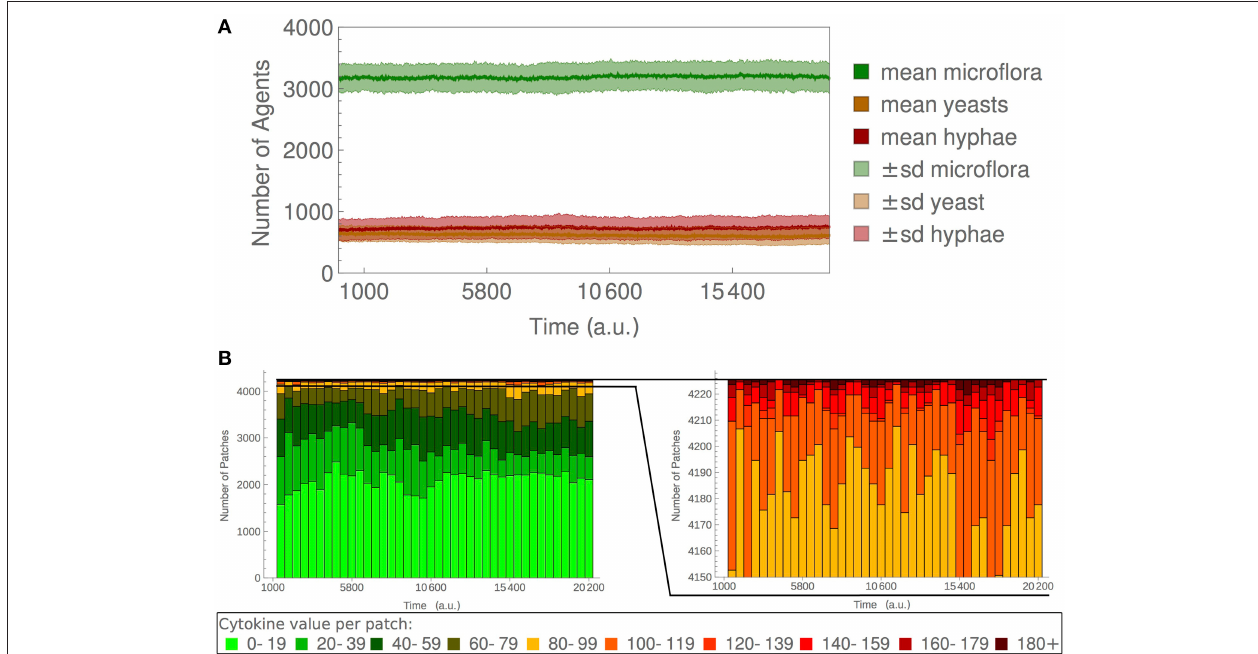
FIGURE 2 | The commensal colonization by C. albicans . The commensal state is characterized by a high amount of microflora agents, a low C. albicans population, and a low degree of inflammation. (A) Dynamics of C. albicans yeast, hyphae and the microflora when simulating the default model. (B) Number of patches with low (0–40), medium (40–80), and high (80 + ) cytokine